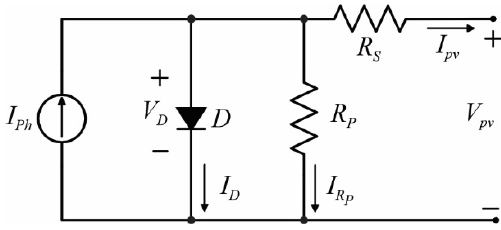
Figure 1. Five-parameters one-diode model.